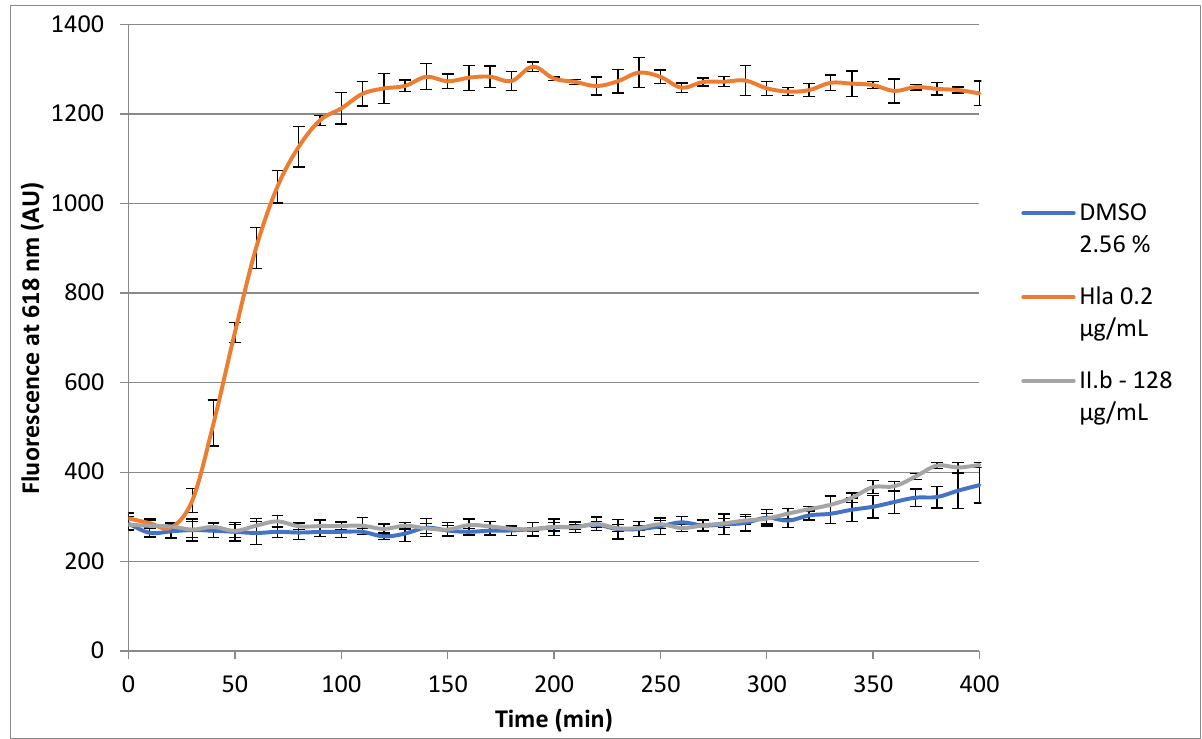
Figure 4. Effect of II.b on the growth of A549 cells.